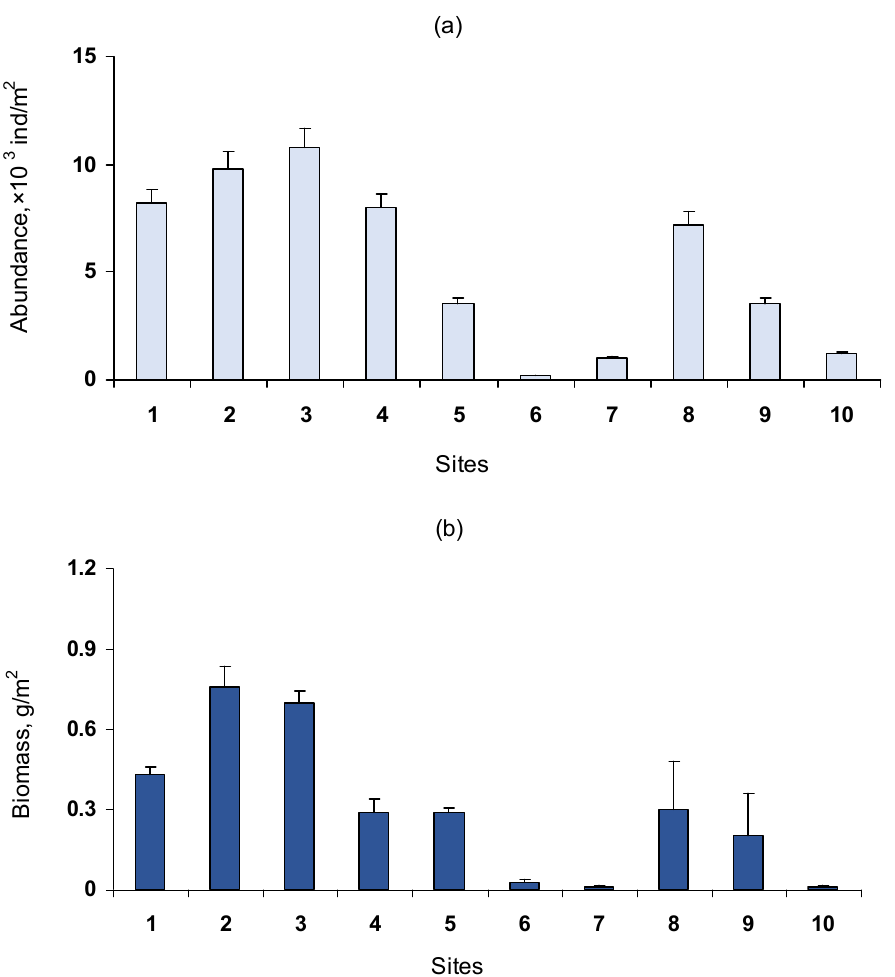
Figure 3. Means + 1SE (n = 3) of abundance, thousands ind/m − 2 ( a ) and biomass ( b ) in wet weight, g/m 2 of meiobenthos at study sites.